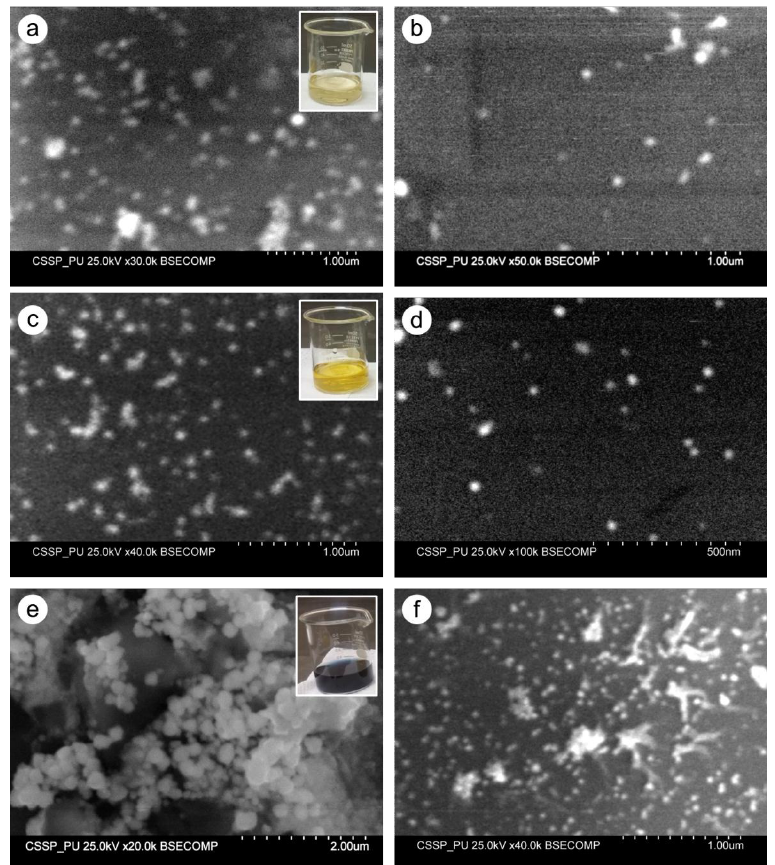
Figure 4. SEM micrographs of sample S3 ( a , b ), S4 ( c , d ), and S5 ( e , f ) presenting the shape and size of preapred AgNPs. The inset showed the the color of correspoding colloidal sample.